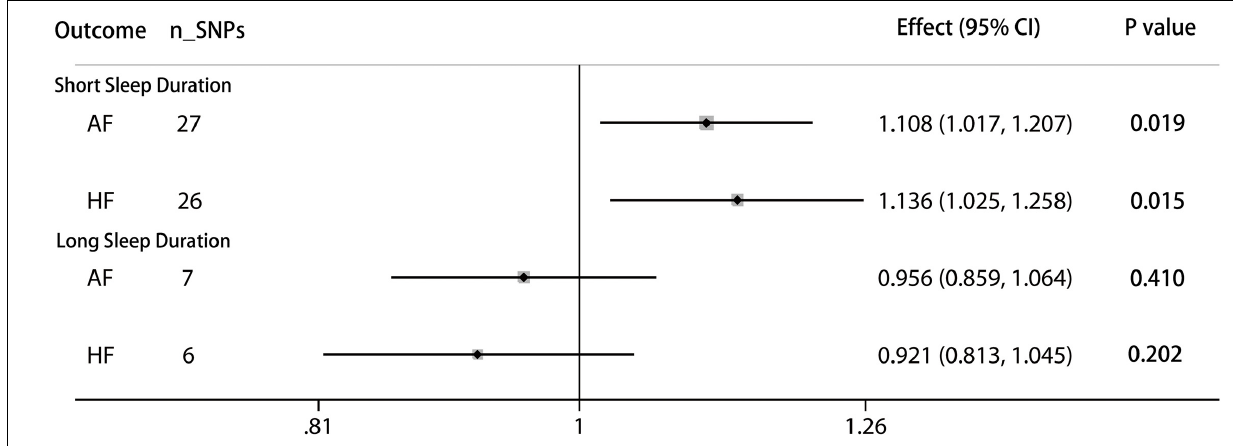
FIGURE 3 | Causal associations between short/long sleep duration and AF and HF. The number of genetic variants, effects, 95% confidence intervals, and P values of associations are contained. n_SNPs, the number of SNPs used as instrumental variables; Effect, the combined causal effect; CI, confidence interval; P value, P value of the causal